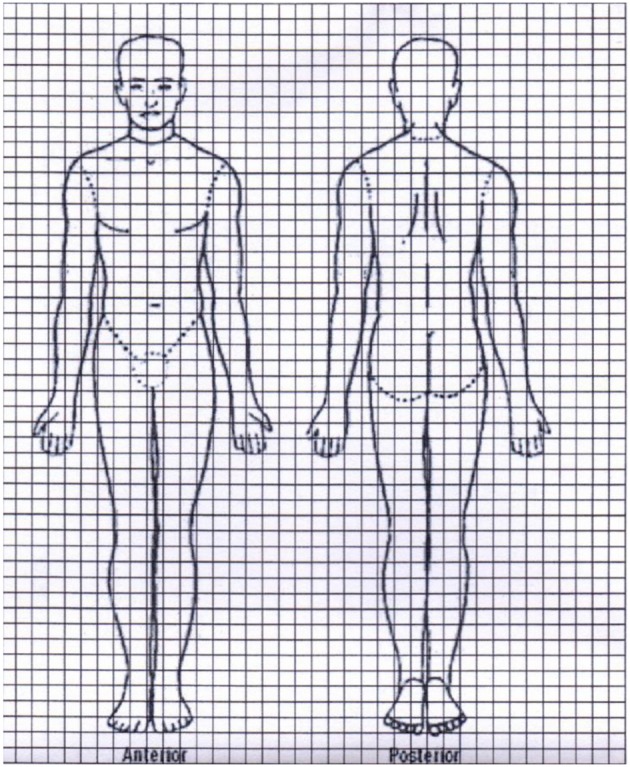
PKDL lesions are plotted on a manikin, and the number of affected squares is recorded (Mondal et al., 2016).